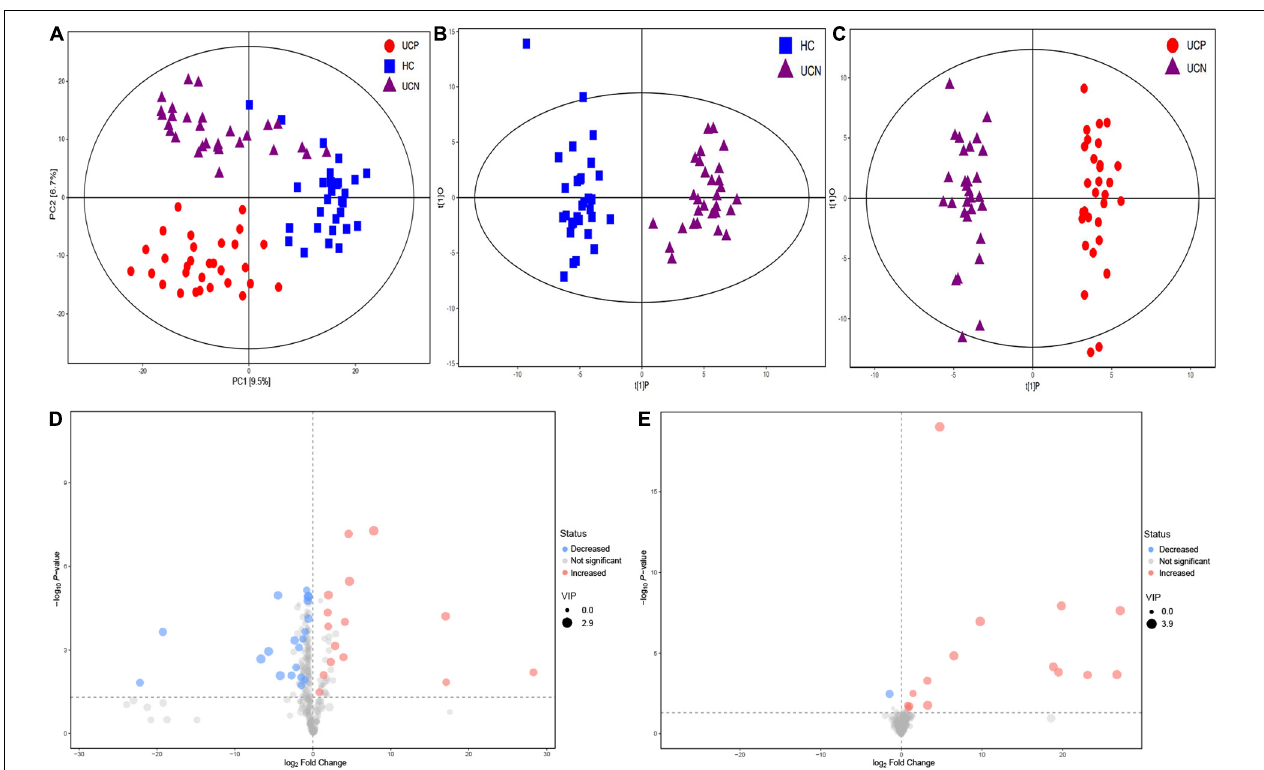
FIGURE 4 | (A) PCA score plot of metabolite profile among the three groups. (B) OPLS-DA score plots of samples from the HC and UCN groups. (C) OPLS-DA score plots of samples from the UCN and UCP groups. (D) Volcano plots of differential metabolites between the UCN and HC groups, where red dots represent increased metabolites and blue dots represent decreased metabolites. (E) Volcano plots of differential metabolites between the UCP and UCN groups, where red dots represent increased metabolites and blue dots represent decreased metabolites. HC, healthy control group; UCN, ulcerative colitis with negative Clostridioides difficile test results; UCP, ulcerative colitis with positive Clostridioides difficile